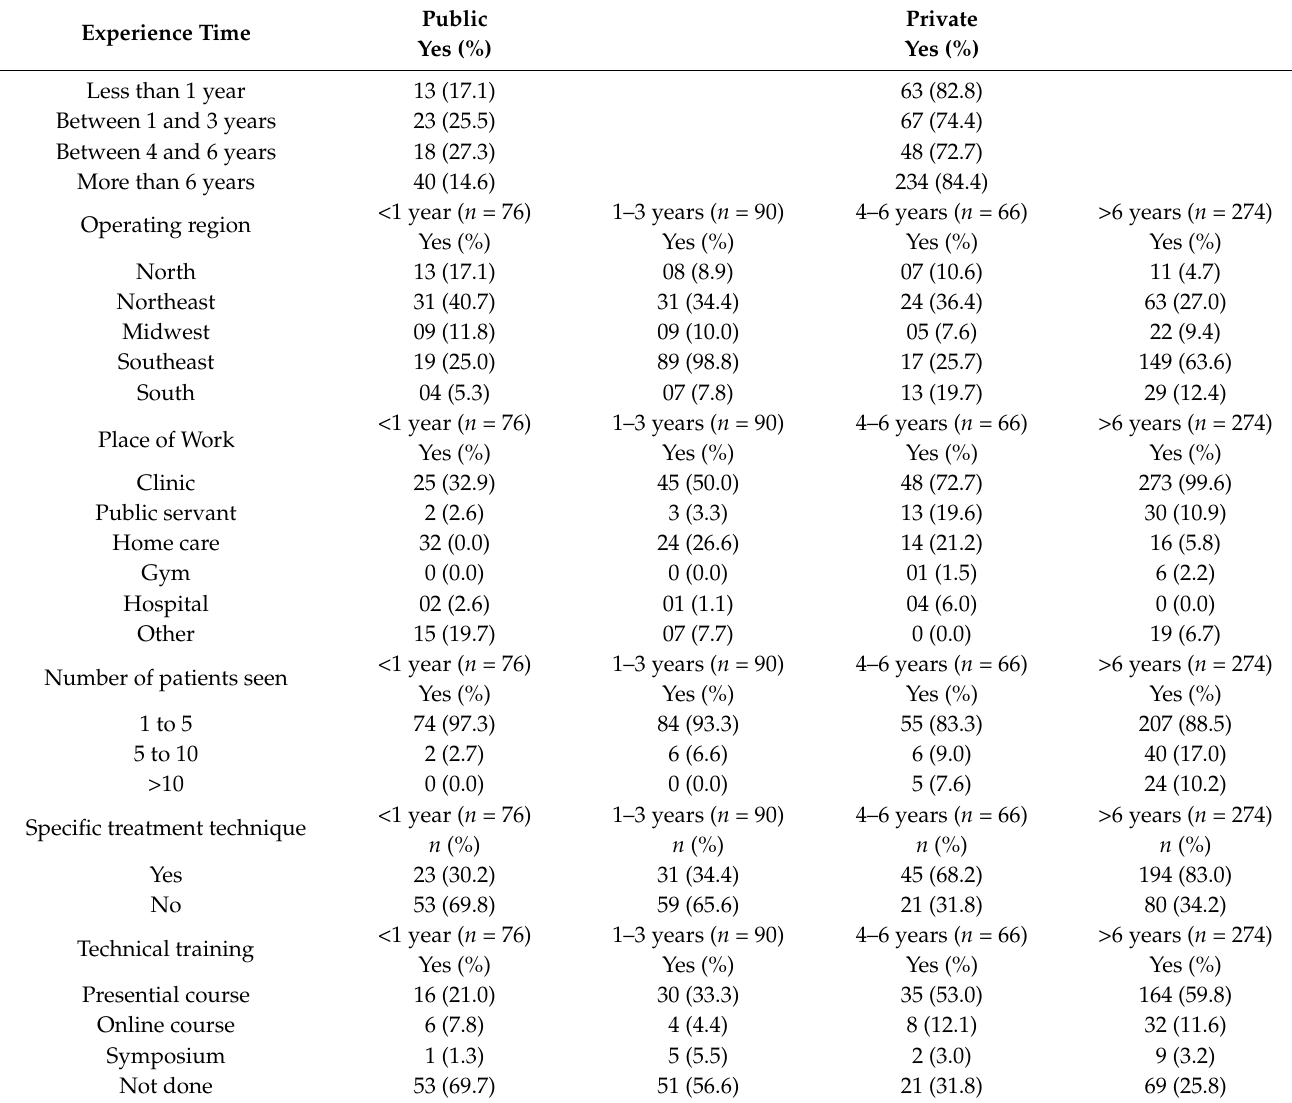
Table 1. Demographic and clinical data of the 506 Brazilian physical therapists, presented according to time since